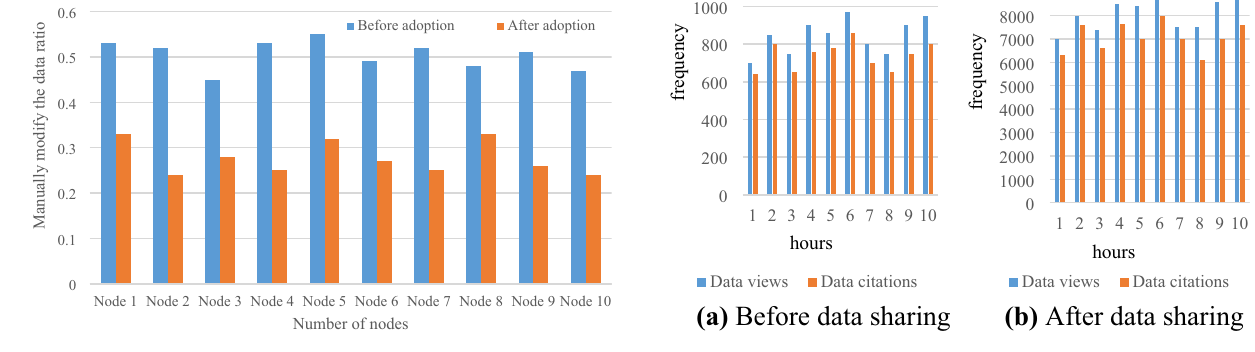
Fig. 8 Manually modified data ratio comparison chart